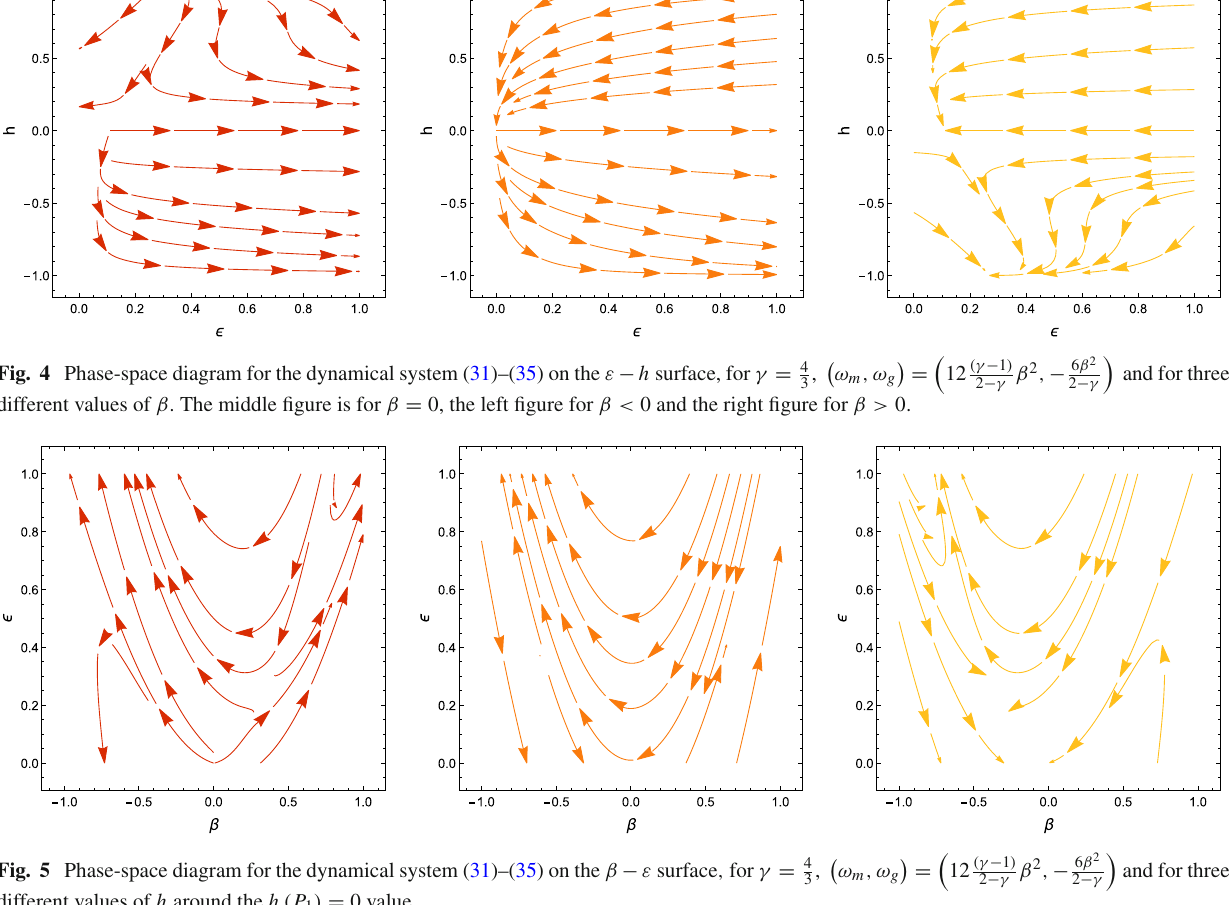
Fig. 3 Phase-space diagram for the dynamical system (31)–(35) on the ω g − h surface, for γ = 4 of β . The middle figure is for β = 0, the left figure for β < 0 and the right figure for β > 0 .